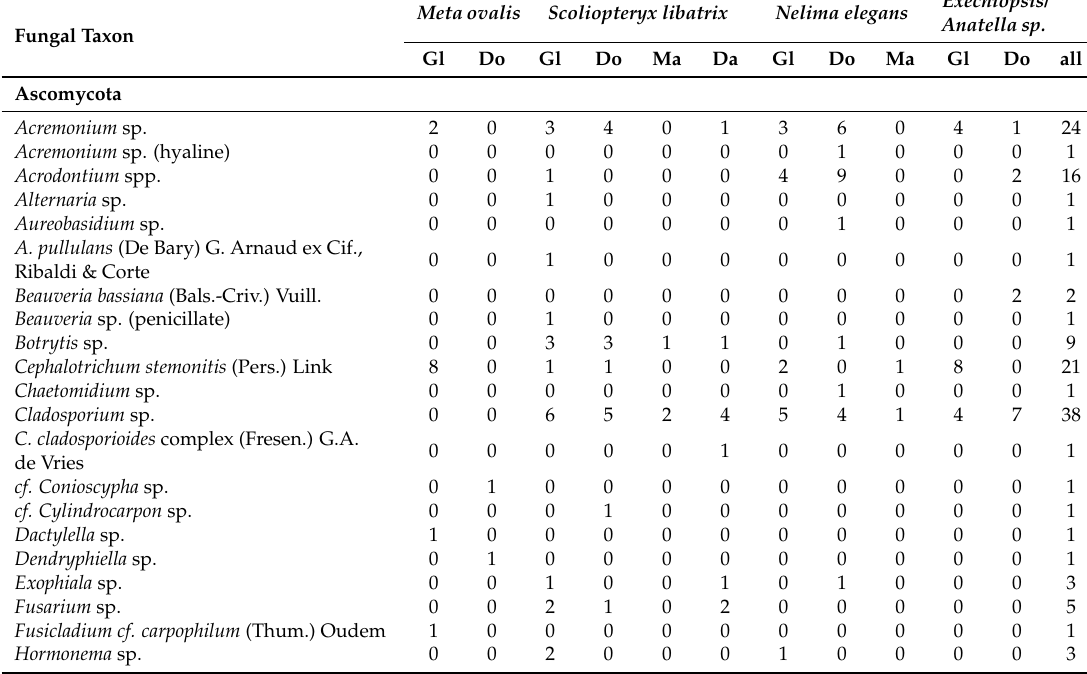
Table 2. Fungal taxa isolated from the external surface of over-wintering arthropods in caves and mines in New Brunswick, Canada over three years (2012–2014). Column figures indicate the number of individuals (plates for Exechiopsis/Anatella sp.) culturing positive for each fungal taxon. Gl = Glebe Mine, Do = Dorchester Mine, Ma = Markhamville Mine, and Da = Dallings